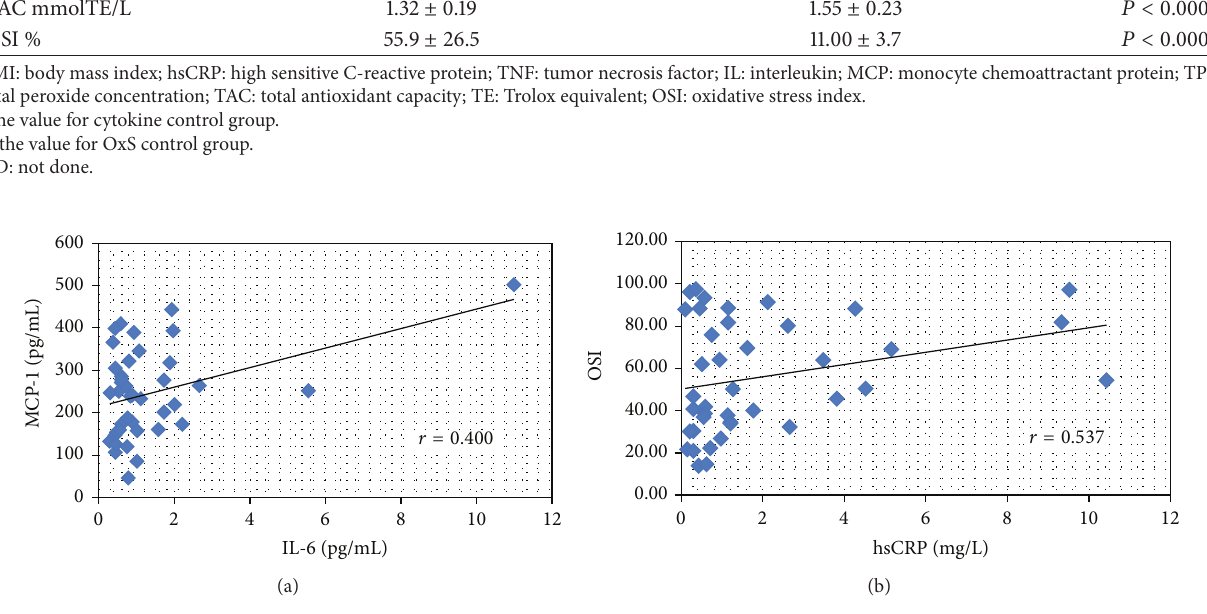
Figure 1: Correlations between inflammatory and oxidative stress markers in patients with acute/subacute allergic contact dermatitis approximately on 5% of body surface. MCP: monocyte chemoattractant protein; IL: interleukin; OSI: oxidative stress index; hsCRP: high sensitive C-reactive protein; TNF: tumor necrosis factor; TAC: total antioxidant capacity; TE: Trolox equivalent; TPX: total peroxide